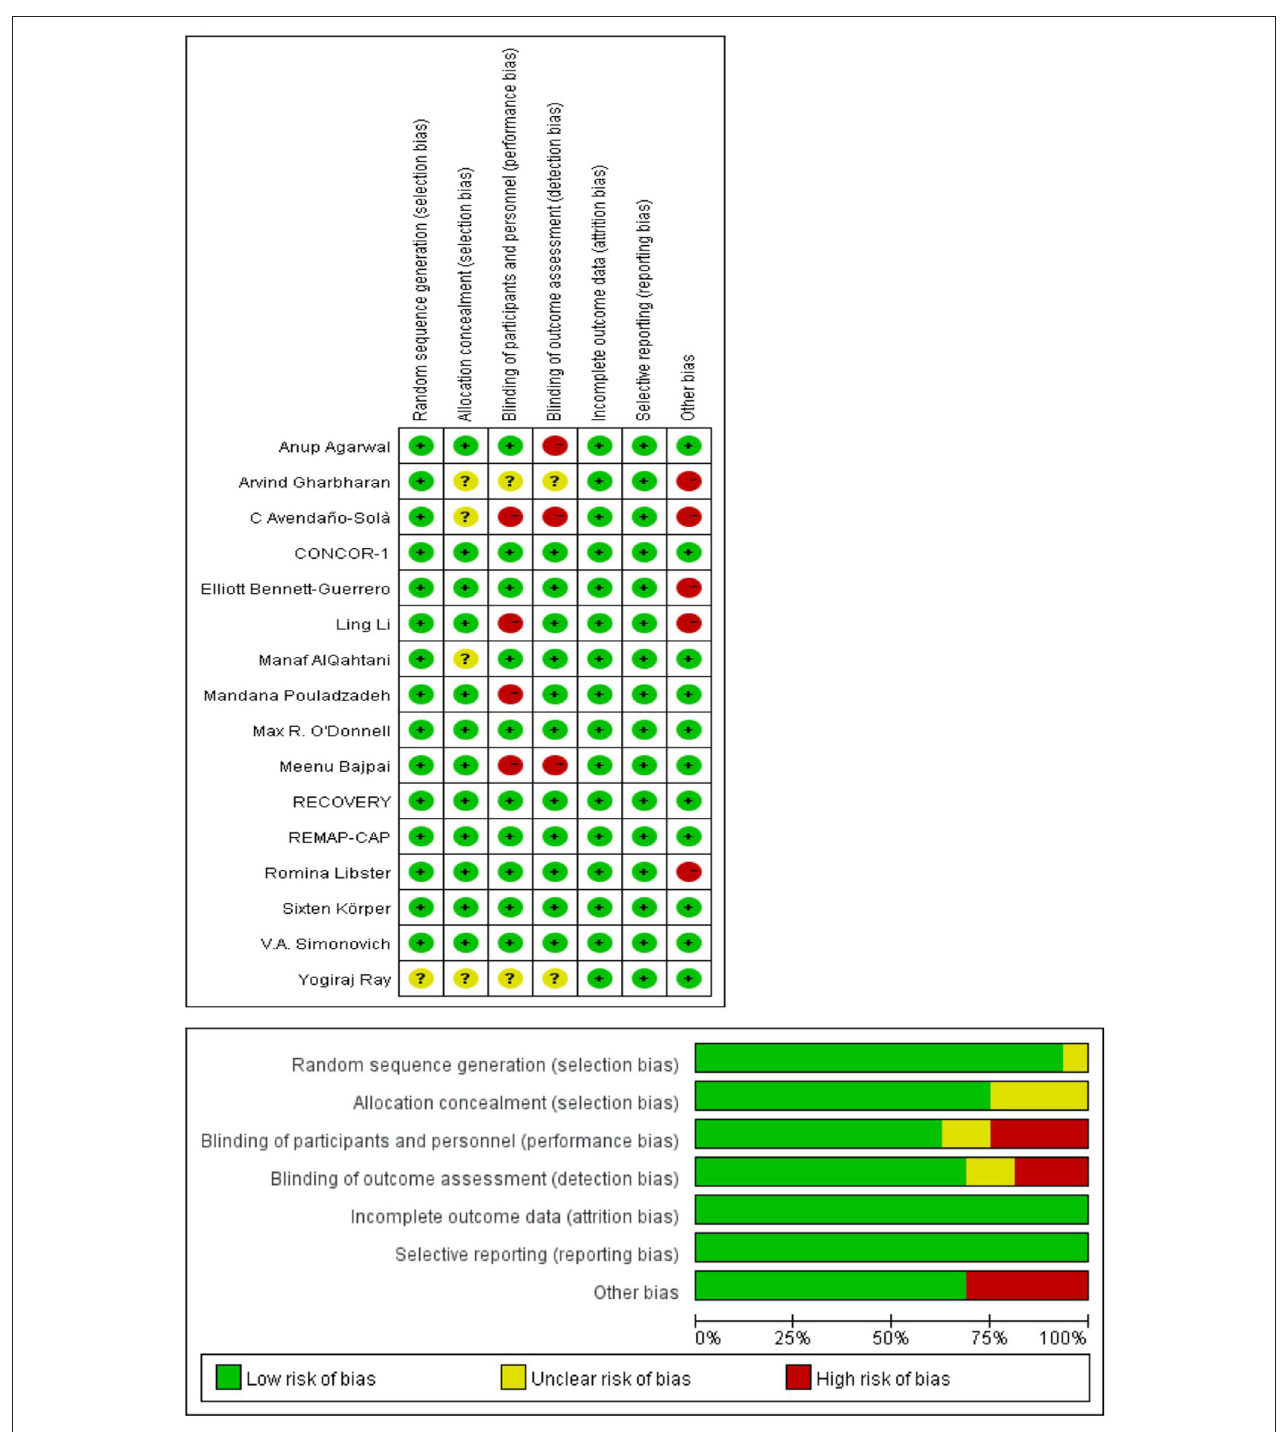
FIGURE 2 | Quality assessment of